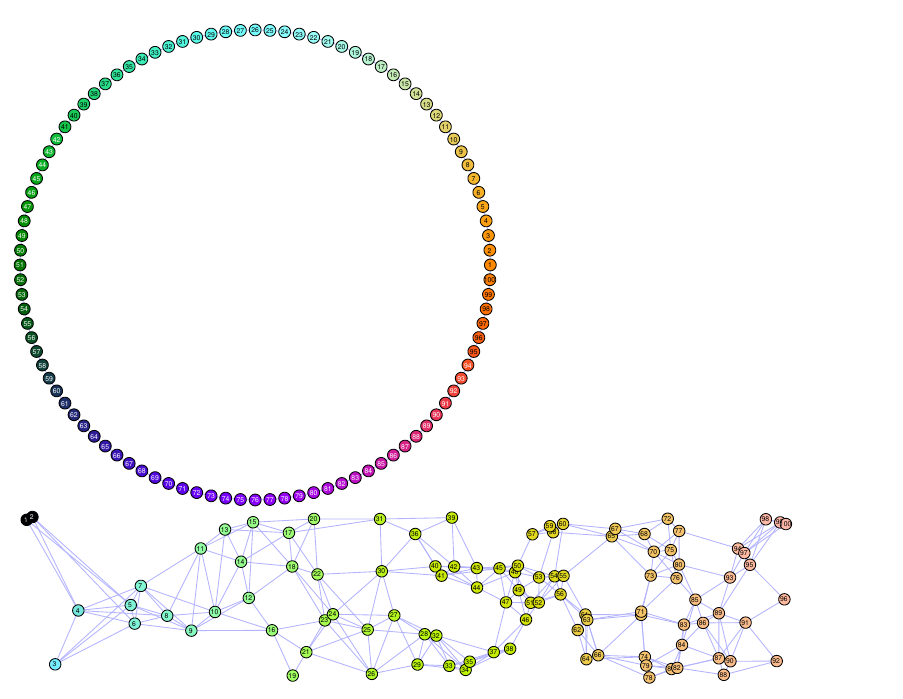
Figure 2. A circular undirected unweighted graph as the domain for classical signal analysis. Each of N = 100 vertices (instants) is connected to the predecessor and successor vertices (top). A general form of a graph, with N = 100 vertices (bottom).